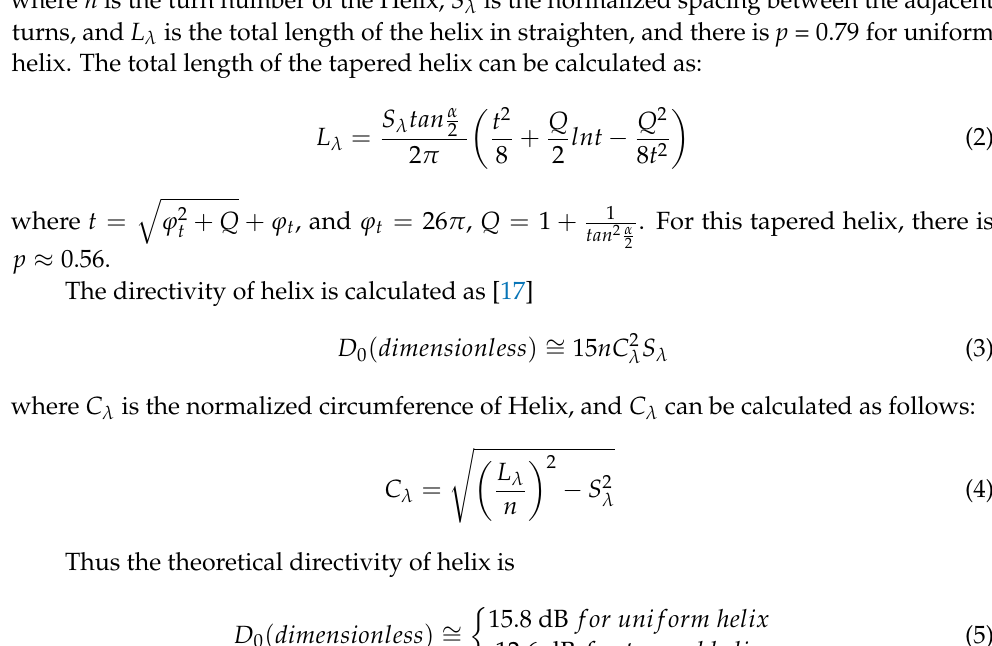
Figure 2. Schematic design of Embedded Helix and dielectric rod antenna.